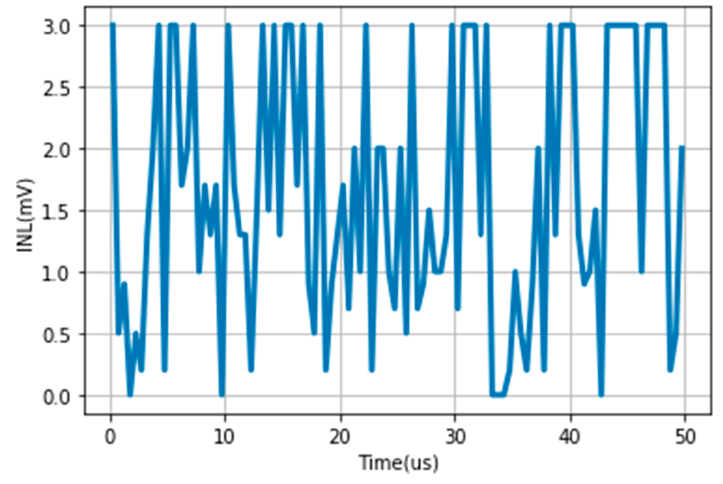
Figure 15. INL simulation for a 4 bit input memristor-based binary-weighted DAC circuit.